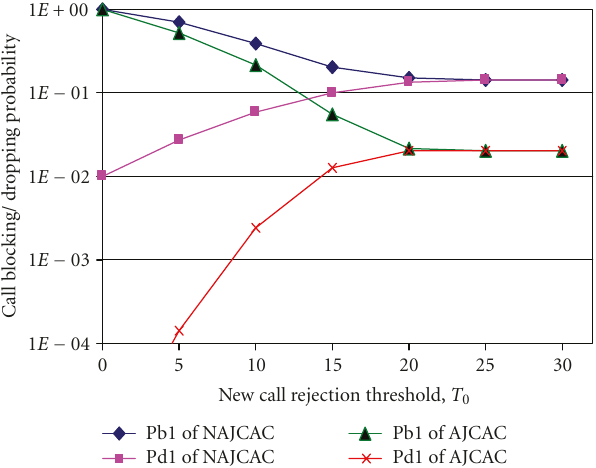
Figure 9: E ff ect of varying the new call rejection threshold, T 0 on the new call blocking probability and hando ff call dropping proba- bility of class-1 calls.